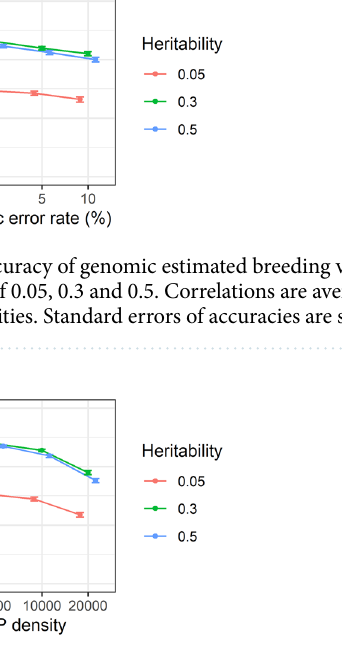
Figure 8. Accuracy of genomic estimated breeding values for 0.5, 3, 10 and 20 K SNP densities over heritabilities of 0.05, 0.3 and 0.5. Correlations are averaged over different generations, replicates, family types and genotypic error rates. Standard errors of accuracies are shown as error